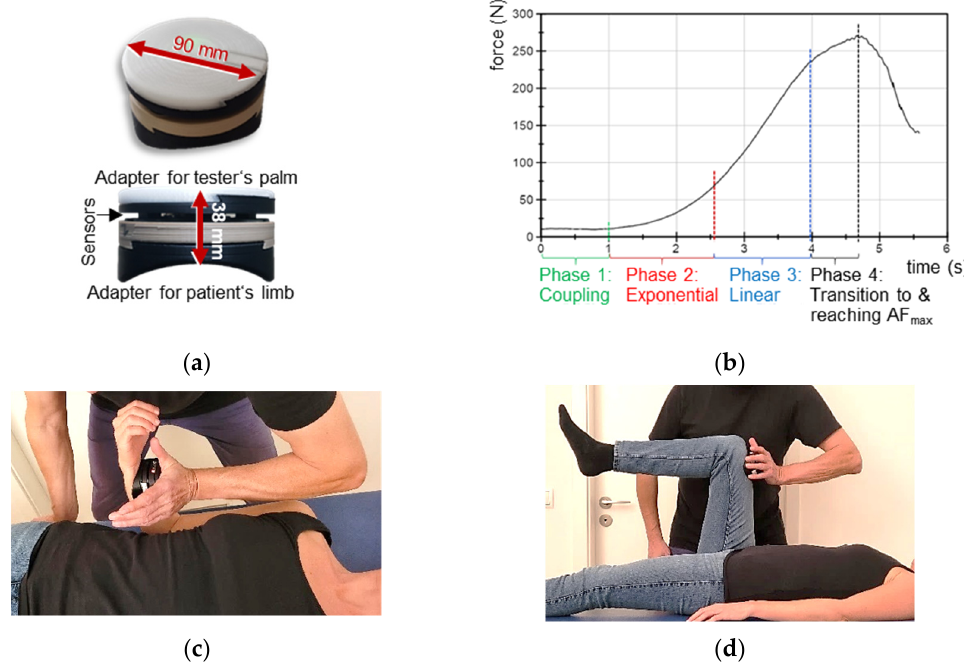
Figure 1. Setting. ( a ) Handheld device; ( b ) force increase during manual muscle test (MMT), including the decisive phases, as was suggested to be optimal by Bittmann et al. [49] and Schaefer et al. [50–52]; starting positions of MMTs of ( c ) elbow flexors and ( d ) hip